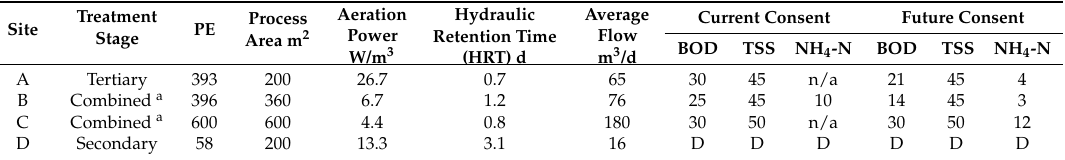
Table 1. Site details and current and future consents for aerated horizontal flow constructed wetlands.